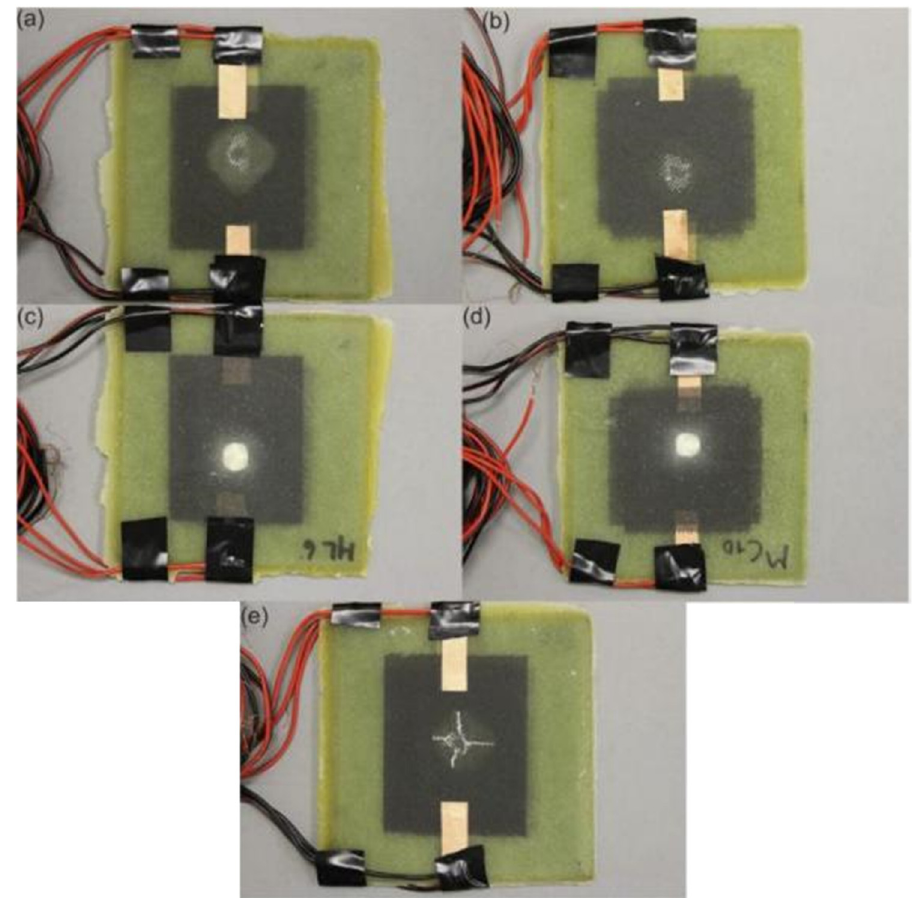
Figure 26: The visible impact damage after seven impact loads ( each impact energy is 10.150 J ) in the test: the impact surface and the back surface of ( a and c ) the sample loaded with parallel CNT fi lms composite material and ( b and d ) the sample loaded with cross - laminated CNT fi lms; and ( e ) impact surface of the second composite specimen loaded with parallel CNT fi lms [ 159 ]